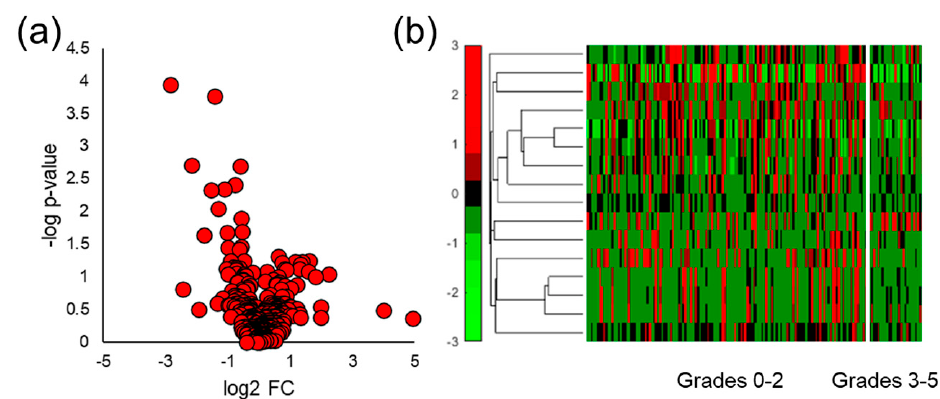
Figure 5. Univariate chemometric analysis of VOCs in human urine to distinguish aggressive grades of prostate cancer. ( a ) The volcano plot shows that more VOCs are downregulated by aggressive prostate cancer in human urine, and ( b ) the hierarchical heatmap of VOCs identified with a p -value < 0.05 shows that the analytes have high variation regardless of sample class. Next, multivariate analyses were implemented to assess the ability of multiple VOCs to separate aggressive prostate cancer. Unsupervised approaches through PCA were utilized in a similar fashion as previously shown for prostate cancer samples. The first two principal components explained 37.7% of the variation in the samples when PCA was used to reduce data dimensionality for the VOCs with a p -value < 0.05 (Supplementary Figure S3a). Even